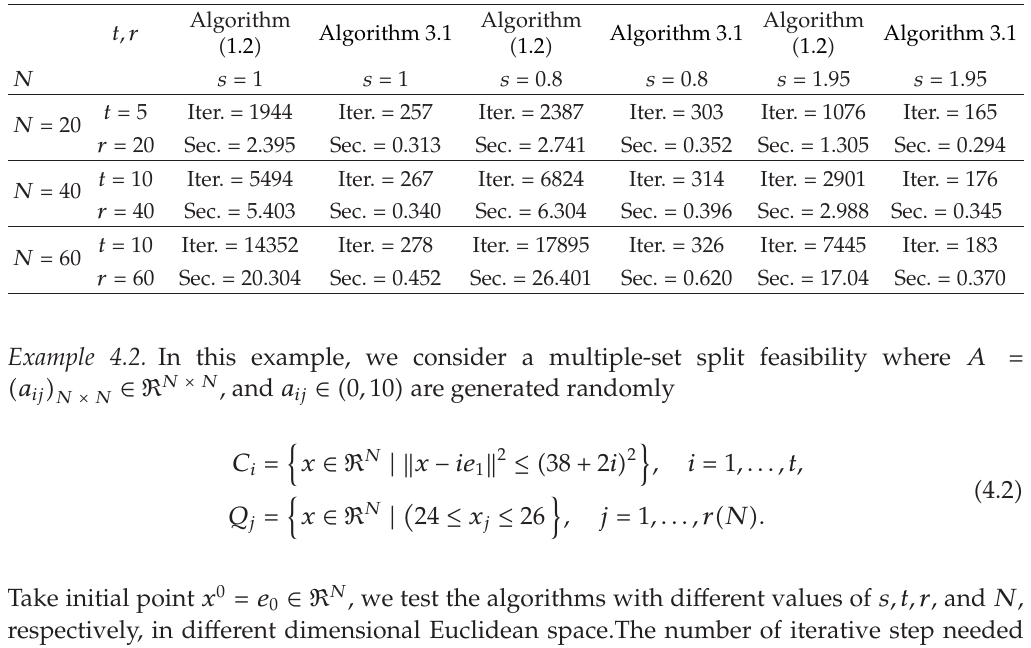
Algorithm (cid:2) 1.2 (cid:3) Algorithm